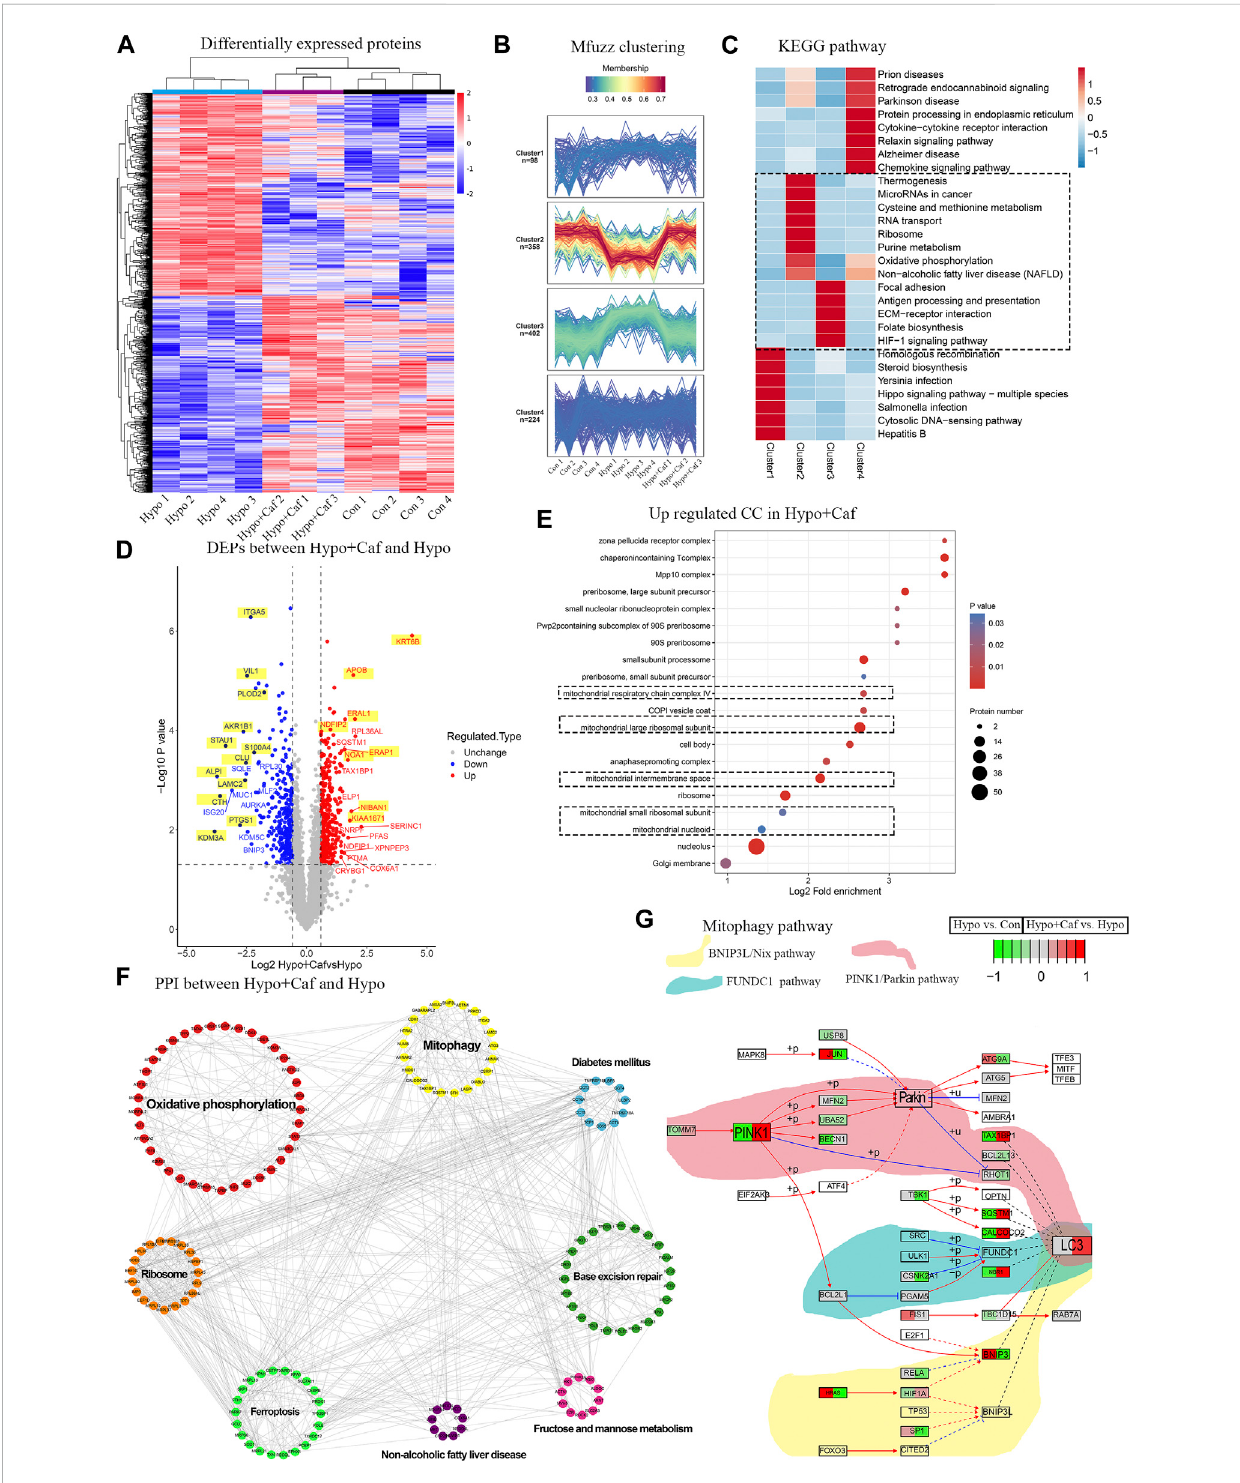
FIGURE 5 Mechanism ofthemitochondrialprotectiveeffect ofcaffeine. (A) Heatmapofthequantitative proteomics.The heatmap withhierarchicalclustering demonstrated Hypo + Caf group was closed to the Control group instead of the Hypo group, and caffeine could essentially recover the expression changes of the DEPs induced by hypoxia, indicating caffeine could relieve the damage caused by hypoxia. One sample in the Hypo + Caf group was removed due to the quality control of the proteomic data. (B) Mfuzz clustering analysis of DEPs. Mfuzz clustering analysis revealed four groups of proteins consisting of 10898, 541358, 428 402, and 431 224 quanti fi ed proteins, respectively. (C) The enrichment KEGG pathways of four clusters. Proteins in cluster 2 were downregulated in the Hypo group but increased in the Hypo + Caf group. In this cluster, oxidative phosphorylation was highly enriched. Proteins in cluster 3 were upregulated in the Hypo group but decreased in the Hypo + Caf group. The HIF-1a signaling pathway, ECM receptor interaction, thiamine metabolism, folate biosynthesis, protein digestion, and absorption were enriched in cluster 3. (D) Volcano map of DEPs between